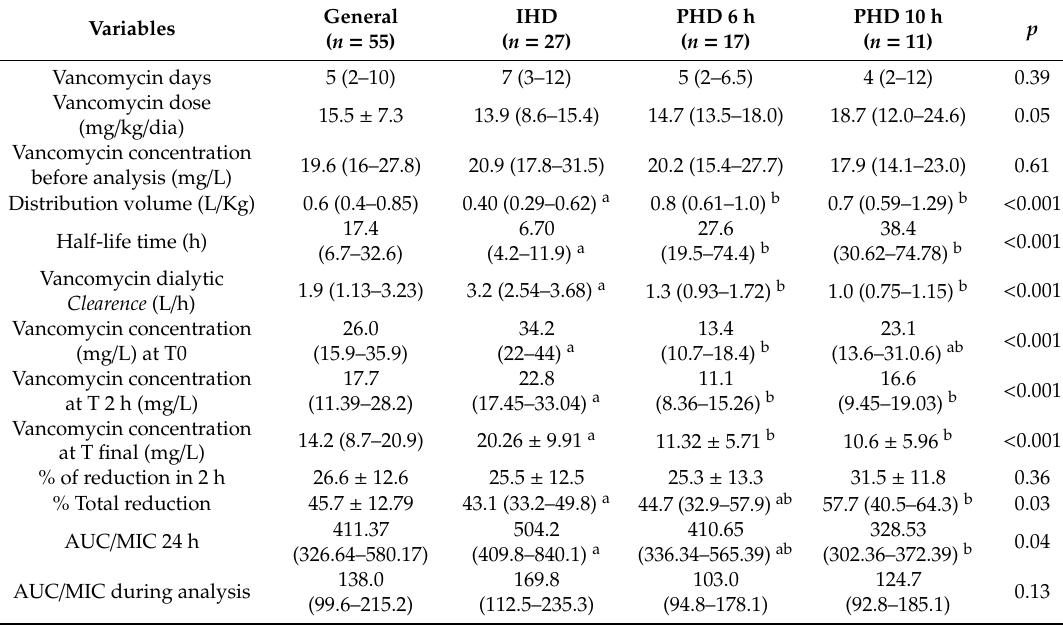
Table 4. Characteristics associated with the prescription of vancomycin and to the pharmacodynamic and pharmacokinetic of the drug in the general population and on the groups according to di ff erent dialytic treatments on the day of the